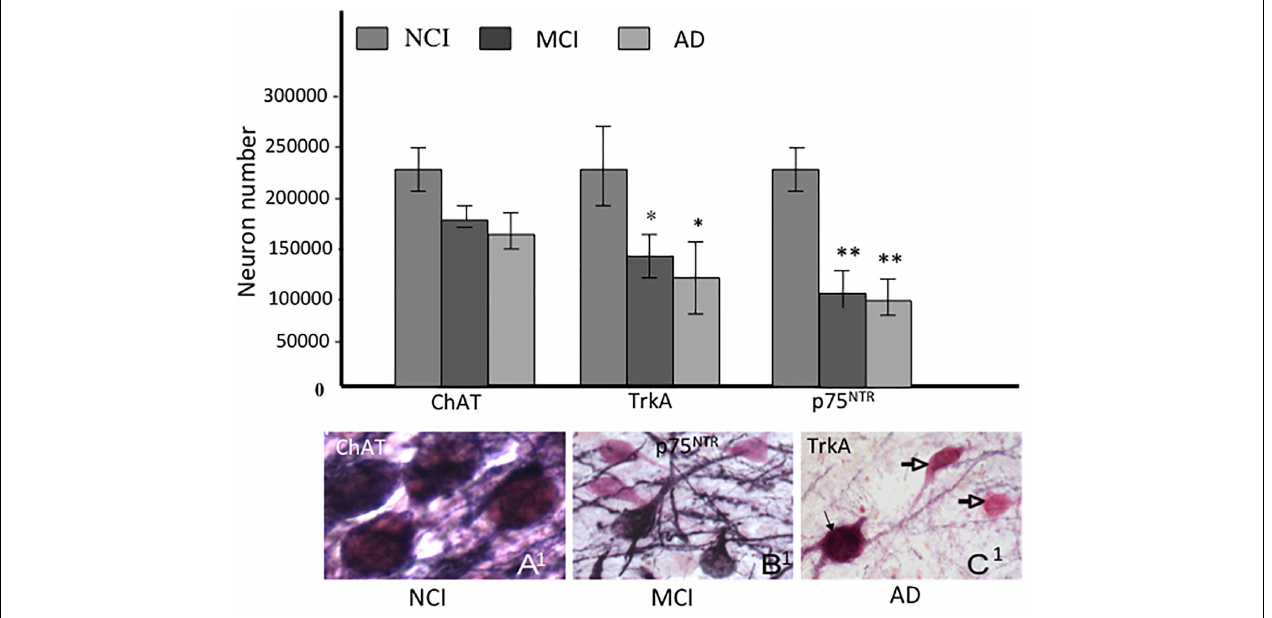
FIGURE 5 | Histograms showing the differential reduction in cholinergic, TrkA and p75 NTR immunoreactive neurons during the progression of AD. A 1 - C 1 . Photomicrographs of dual labeled nucleus basalis neurons showing phenotypic downregulation of p75 NTR (dark blue) compared to ChAT (pink) positive neurons between no cognitive impairment (NCI), mild cognitive impairment (MCI) and AD. Note the loss of p75 NTR immunoreactive staining of ChAT-positive cells in MCI and AD (open arrows). Black arrow indicates dual stained neuron in AD (C 1 ), ∗ and ∗∗ indicate p < 0.05 and 0.01, respectively.